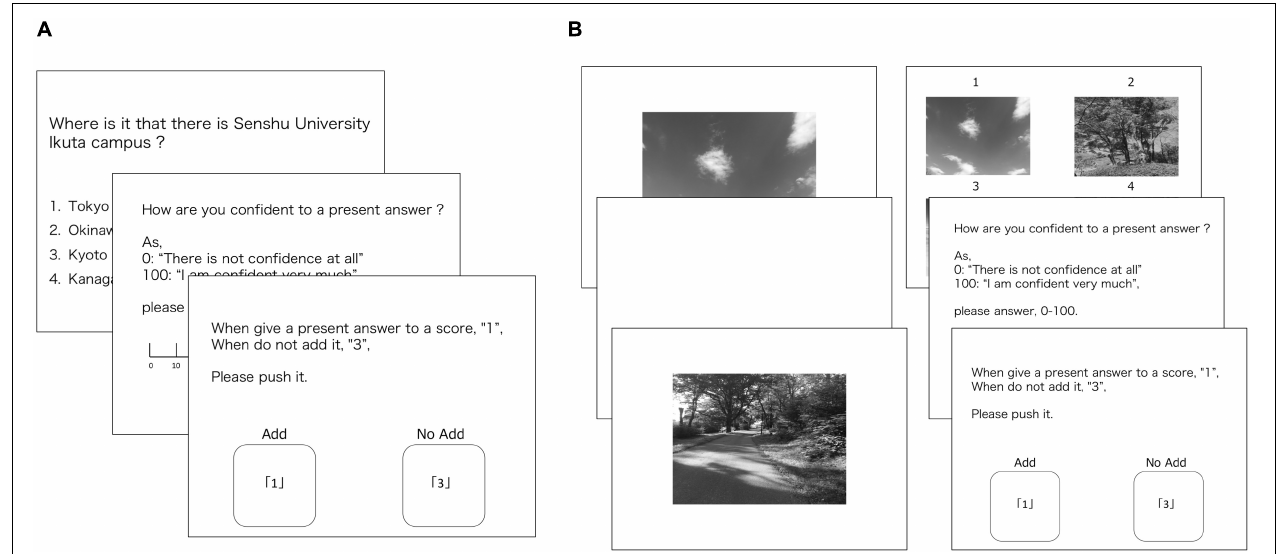
FIGURE 1 | (A) Metacognitive general knowledge task. (B) Metacognitive recognition